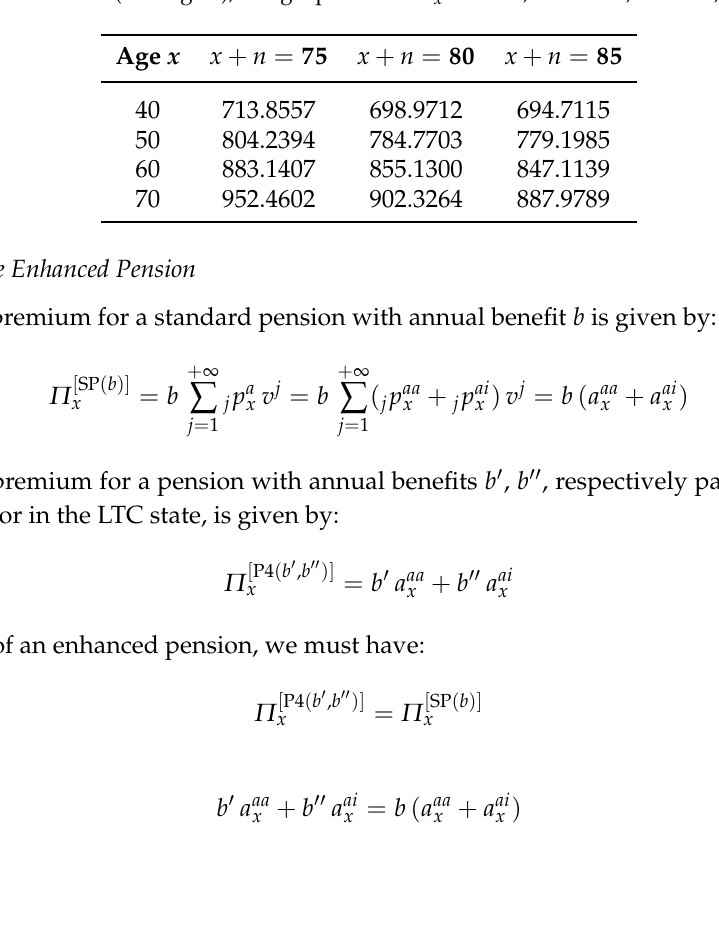
Table 7. Product 3b (Package b); single premium Π